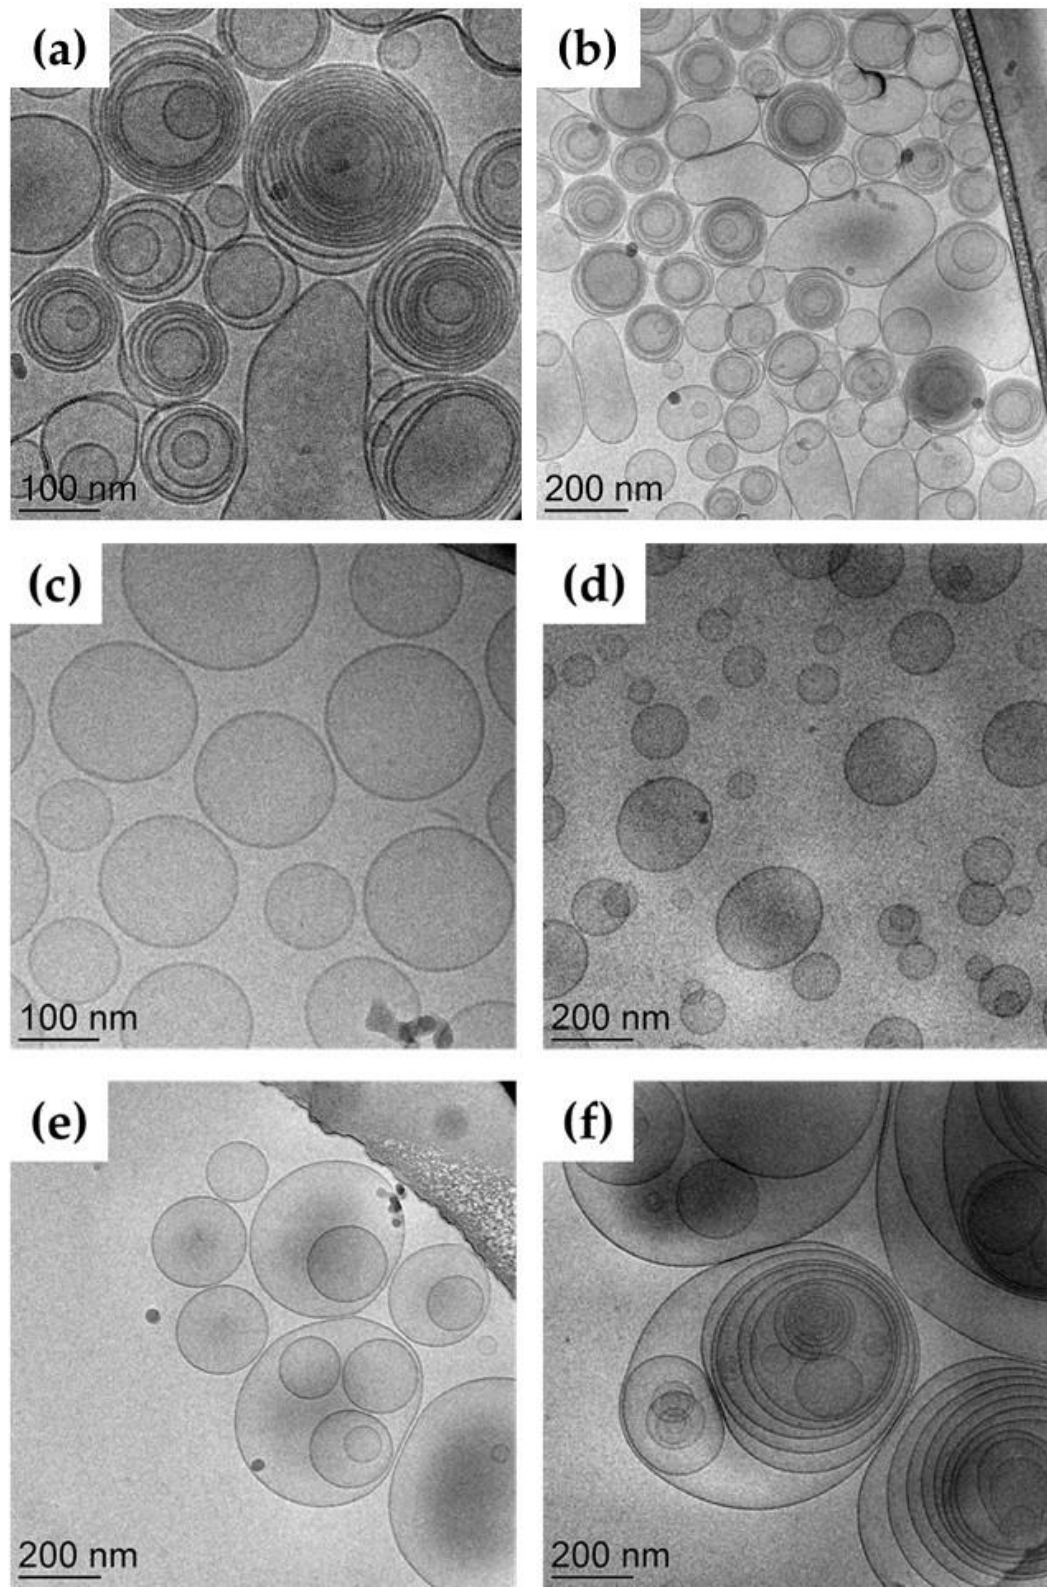
Figure 2. Cryo-TEM images of ET ( a , b ) TET-1 ( c , d ) and TET-2 ( e , f ).